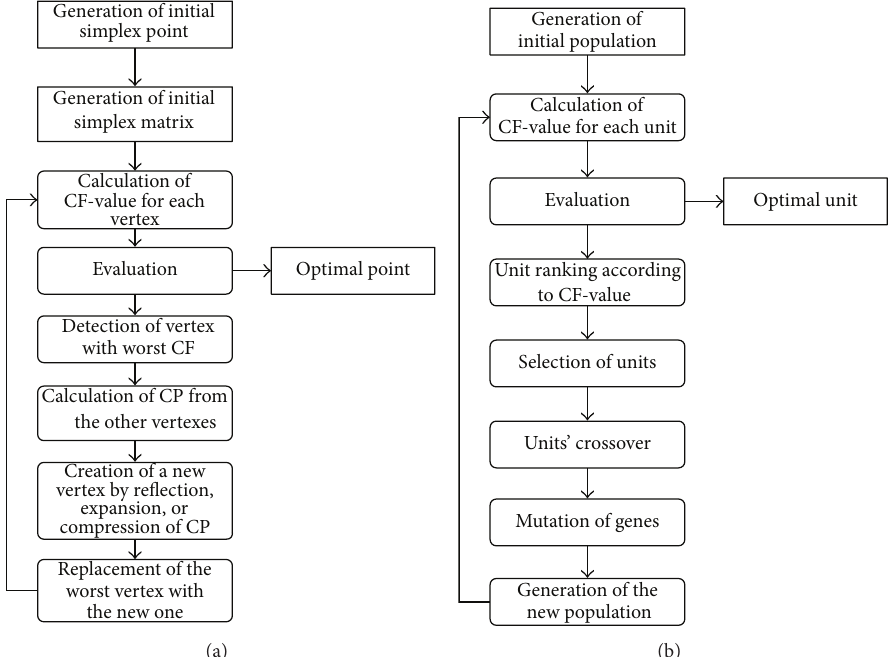
Figure 1: Block diagrams of (a) simplex and (b) genetic algorithm methodology. CF represents criterion function and CP is the centroid point of the hyperspace excluding the worst